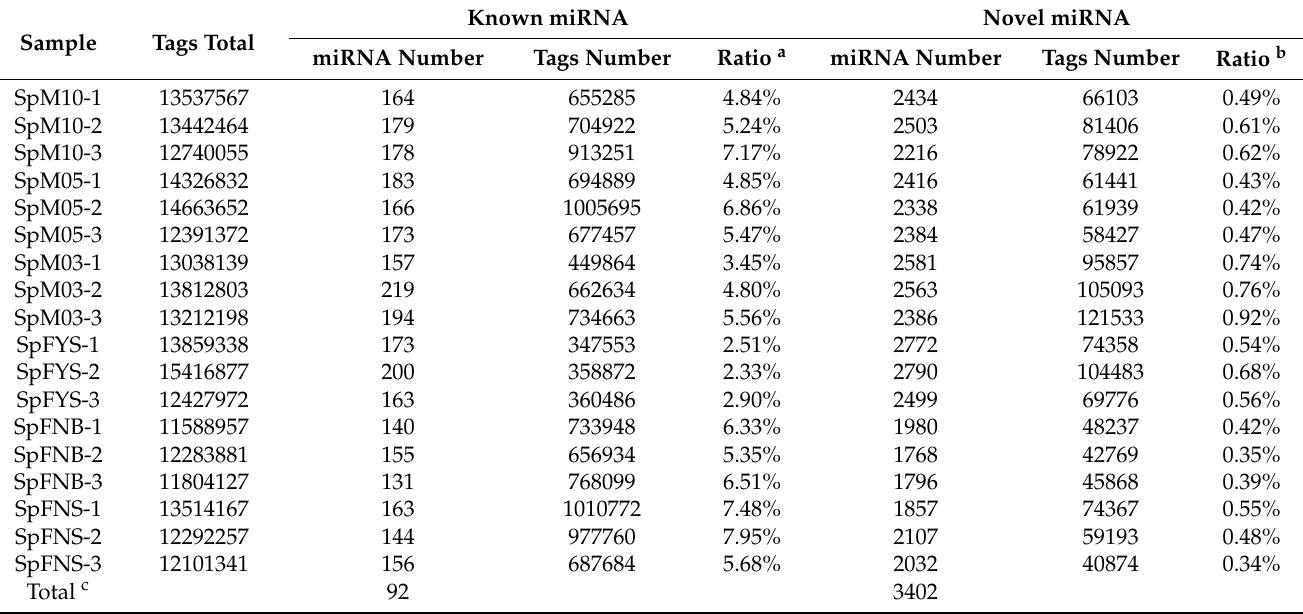
Figure 1. Frequency distribution of small RNA length. FNS, female flower without stigma (0.3 mm in diameter); FNB, female flower without stigma (0.5 mm in diameter); FYS, mature female flower with stigma; M03, male flower (0.3 mm in diameter); M05, male flower (0.5 mm in diameter); M10, male flower (1.0 mm in diameter). Table 2. Summary of miRNAs identified in each sample.